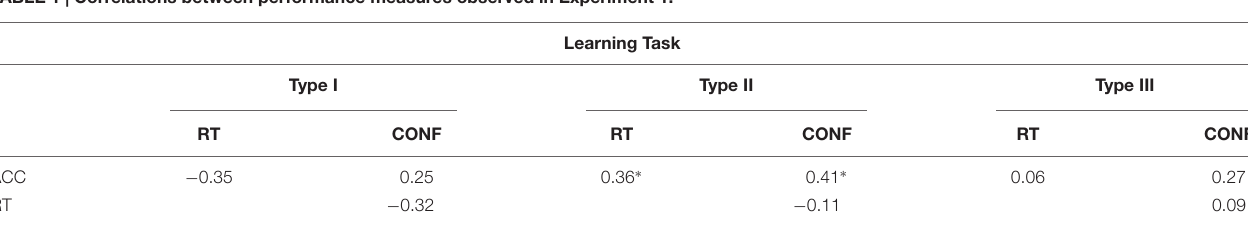
FIGURE 1 | Mean accuracy (A), confidence judgments (B), and log 10 transformed response times (C) in the last five learning blocks. Results are shown separately for all participants (left column) and for participants who successfully learned all three tasks (right column). Blocks are counted relative to the end of the learning session. Error bars represent 95% within-subjects confidence intervals computed following Cousineau (2005) and Morey (2008). TABLE 1 | Correlations between performance measures observed in Experiment